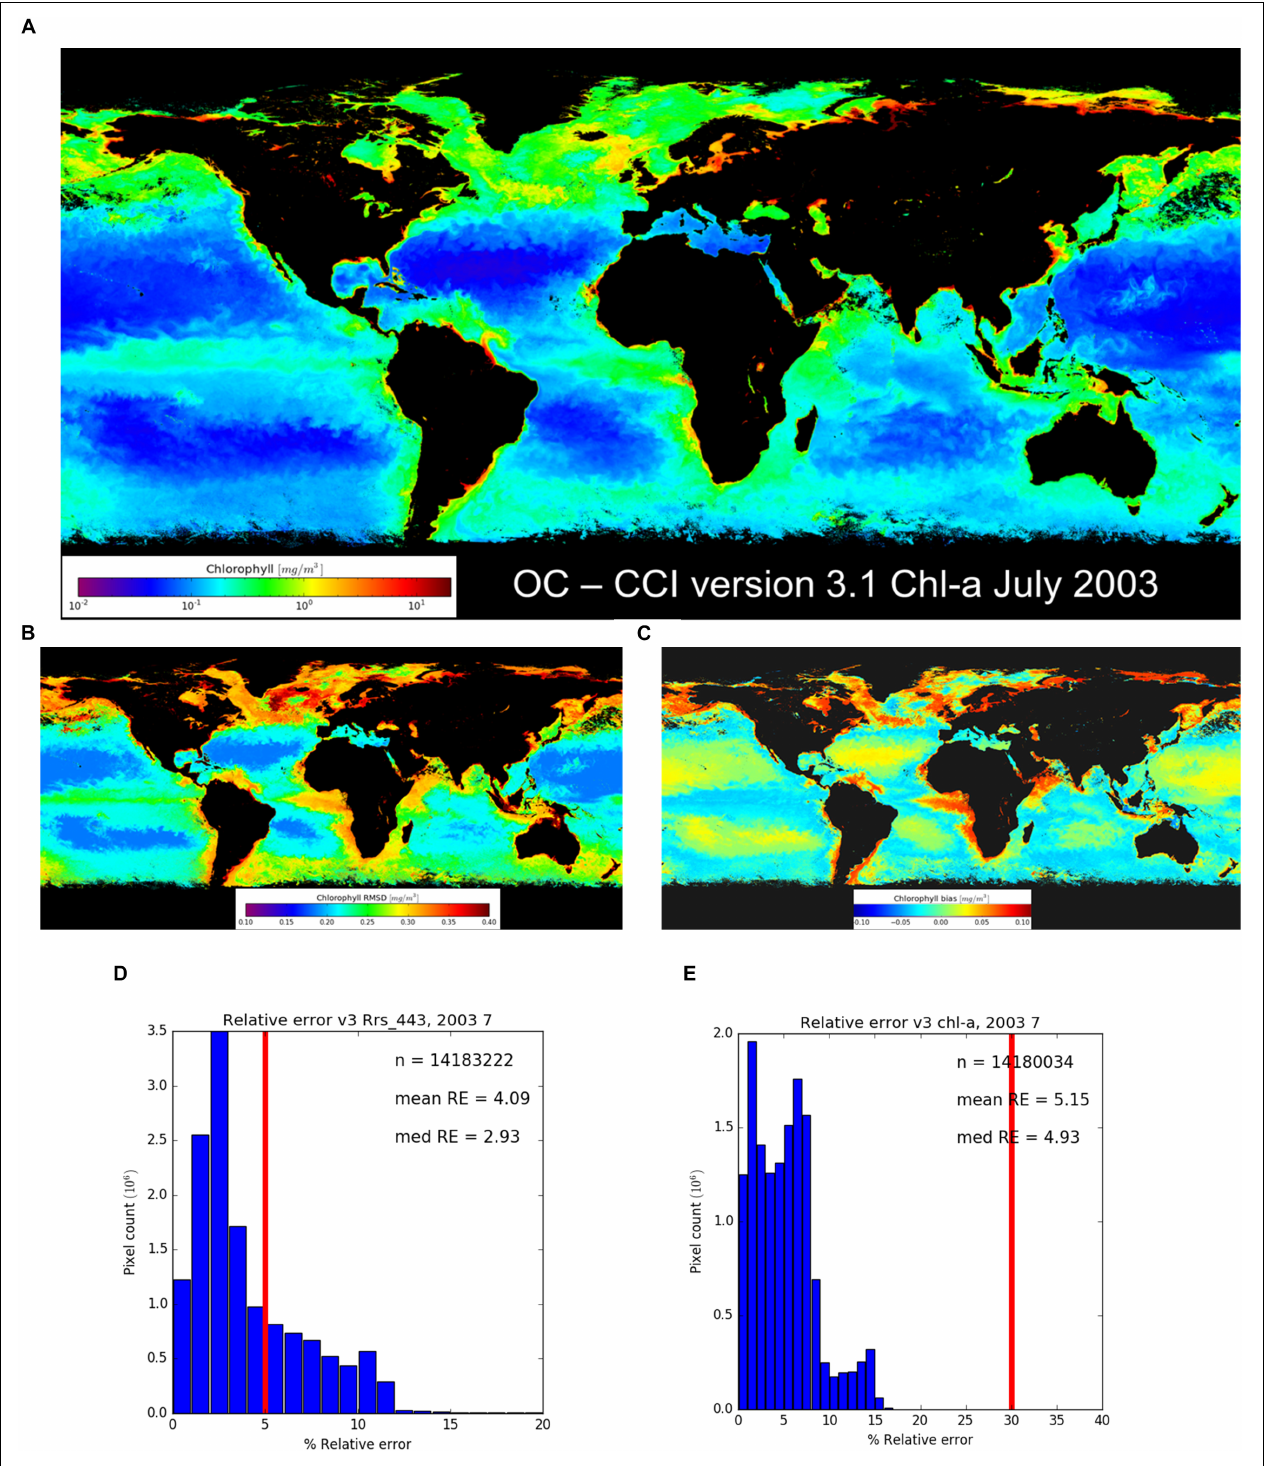
FIGURE 3 | ESA Ocean Colour Climate Change Initiative version 3.1 monthly images for July 2003: (A) chl-a concentration, (B) RMSE, and (C) bias expressed as log10chl-a; comparisons of monthly relative error with GCOS uncertainty criteria for (D) R rs 443 nm and (E) chl-a for July 2003.